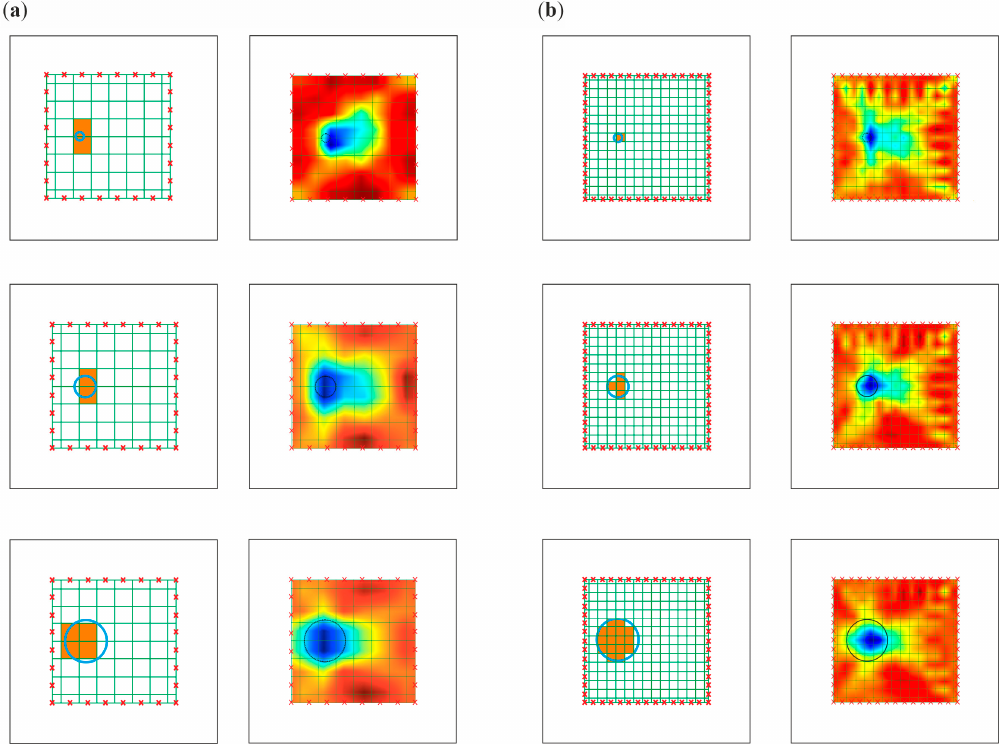
Figure 15. Pixel grid for the direct travel time measurement method: ( a ) division into 64 pixels; ( b ) division into 225 pixels.